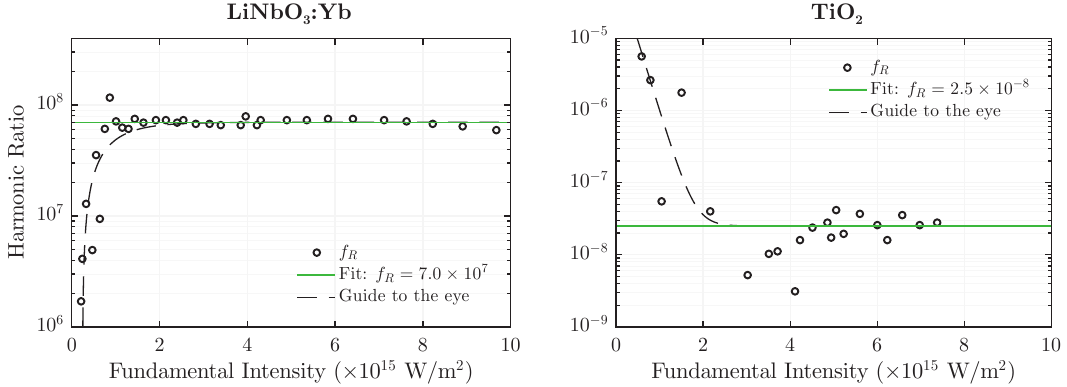
Figure 7. Harmonic ratio f R of LiNbO 3 :Yb- ( left ) and TiO 2 -nanopowder ( right ) as a function of the fundamental peak intensity I ω at a wavelength λ ω = 1400nm ( left ) and λ ω = 1460nm ( right